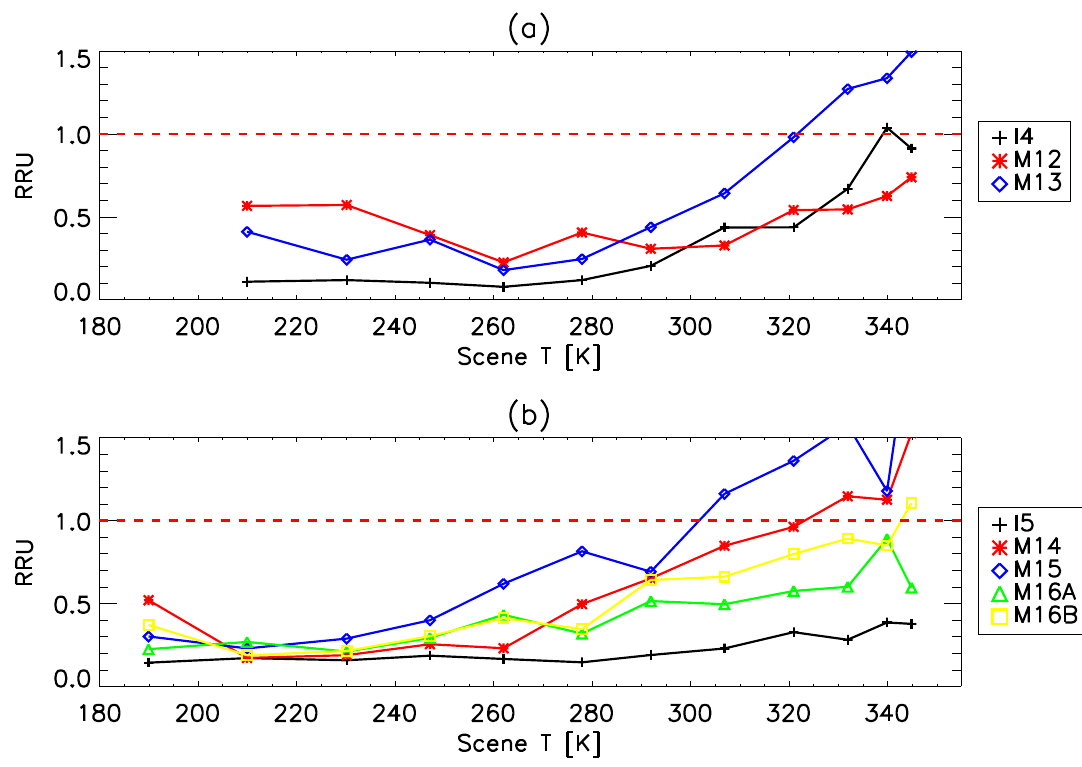
Figure 5. Plots show the measured uniformity metric as a function of scene temperature for the MWIR bands ( a ) and for the LWIR bands ( b ). Measured data was taken from nominal plateau, HAM side A, electronics side A, FPA temperature 80.5 K using the worst case